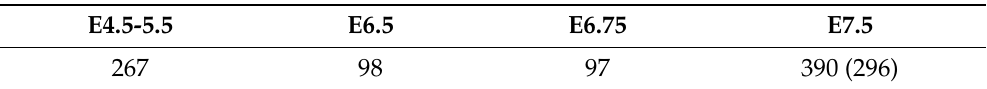
Table 2. The number of single cells at four embryonic time points included in Dataset 2. For E7.5, the gene expression profiles of 296 single cells were